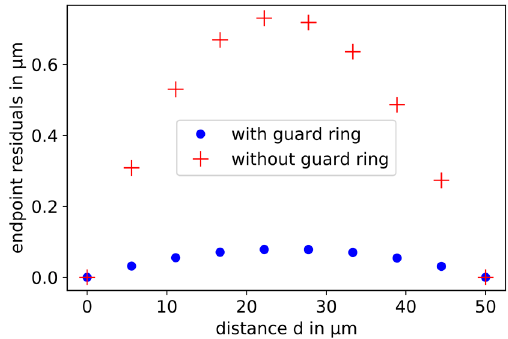
Figure 7. Comparison of the residuals of the simulated capacitive displacement measurement with (blue dots) and without (red crosses) guard rings. Due to the reduction in the distortion of the electric field lines at the edges of the working electrodes, the guard rings lead to a smaller